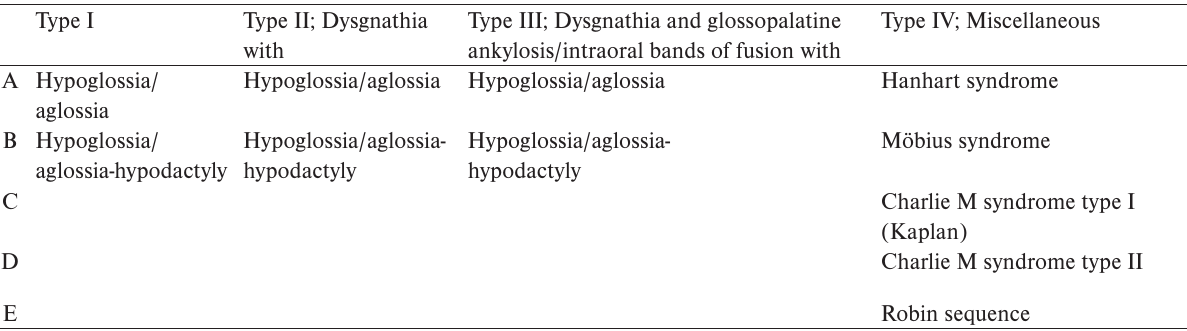
Table 4. New classification of former OLHS: Oromandibular and limb hypogenesis malformations (OLHM). Type